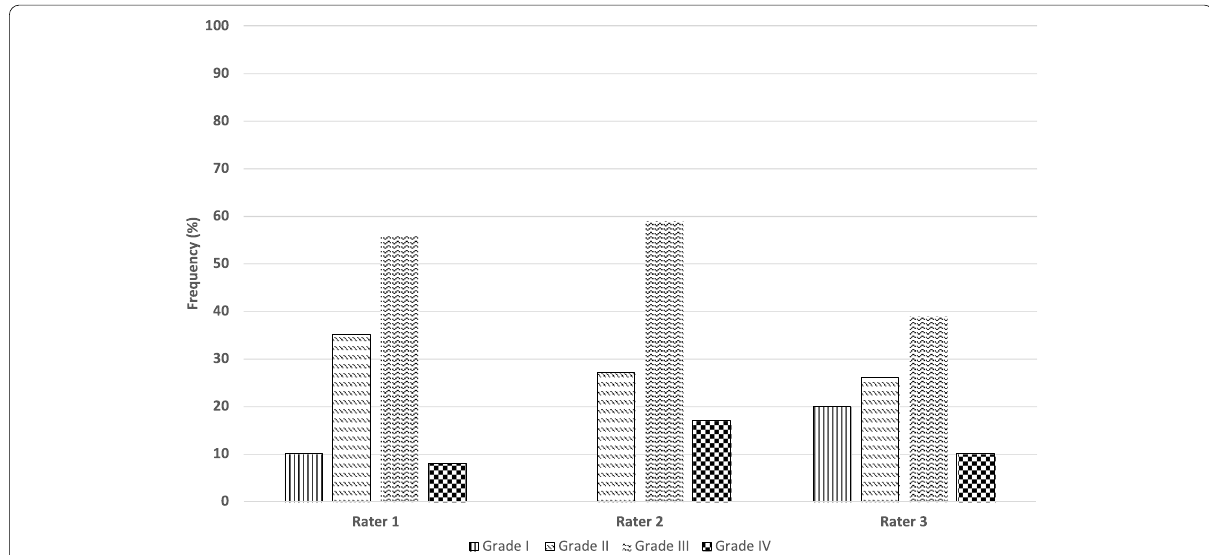
Fig. 2 The distribution of the AMADEUS grade assignments among rater 1 to rater 3